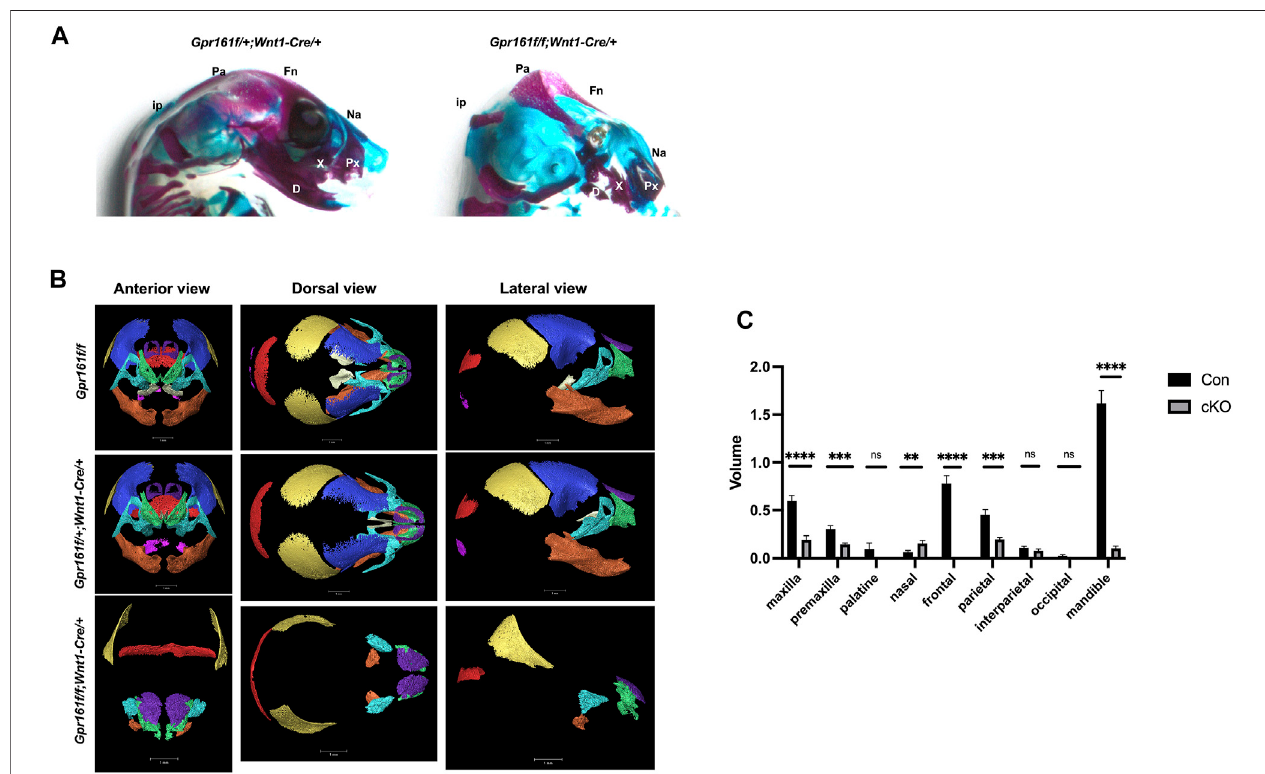
FIGURE5| Thecraniofacialskeletalanalysisin Gpr161 cKOfetusesatE17.5. (A) Theskeletonstainingofheadsfrom Gpr161 f/+ ;Wnt1-Cre/+ and Gpr161 f/f ;Wnt1- Cre/+ with Alcian blue and Alizarin Red S (n (cid:1) 3). Fn: frontal bone; Pa: parietal bone; ip: interparietal bone; Na: nasalbone; Px: premaxilla; X: maxilla; D: mandible. (B) 3D reconstruction of microCT images of heads from Gpr161 f/f (n (cid:1) 1), Gpr161 f/+ ;Wnt1-Cre/+ (n (cid:1) 2) and Gpr161 f/f ;Wnt1-Cre/+ (n (cid:1) 3) at E17.5. frontal bone: blue, parietal bone: yellow, interparietal bone: red, occipital bone: pink, nasal bone: purple, palatine bone: beige, maxilla: turquoise, premaxilla: green, mandible: orange (C) Quantitative volume measurement of identi fi ed craniofacial bones. Con combines the volume measurement from Gpr161 f/f and Gpr161 f/+ ;Wnt1-Cre/+ .